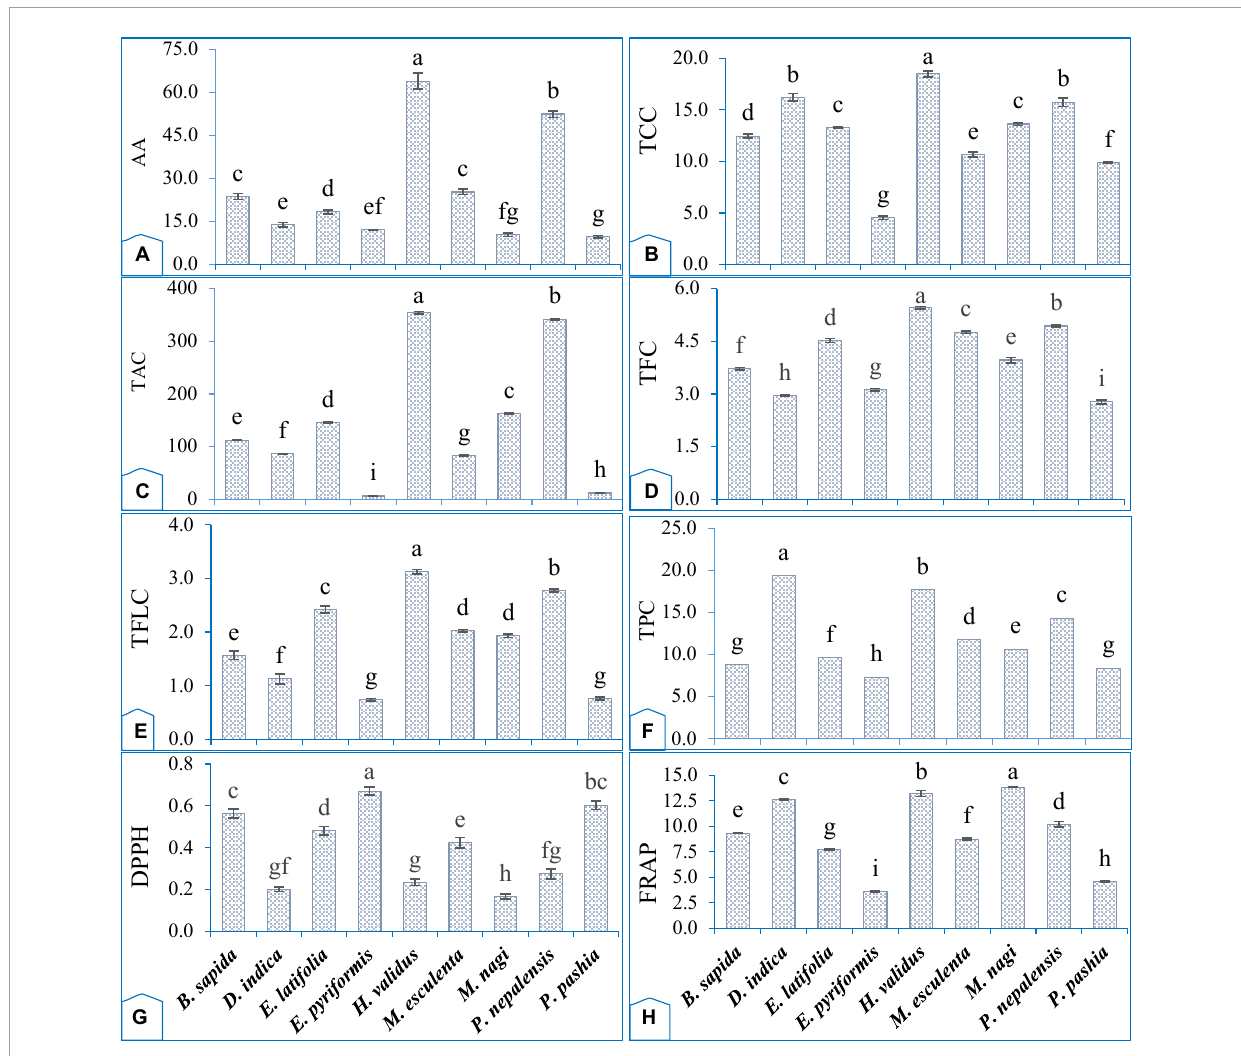
FIGURE3 Functional attributes of wild edible fruits grown in the eastern Himalayas, India. (A) Ascorbic acid content (AA, mg/100 g fw); (B) total carotenoids content (TCC, mg/100 g fw); (C) total monomeric anthocyanins content (TAC, mg/100 g fw); (D) total flavonoids content (TFC, mg QE /g); (E) total flavonol content (TFLC, mg QE /g); (F) total phenol content (TPC, mg GAE /g); (G) DPPH antioxidants capacity (DDPH, IC 50 value mg /mL); (H) FRAP antioxidants capacity (FRAP, mg AAE/g) content in wild edible fruits. IC 50 ascorbic acid (0.012 ± 0.002). Mean value of three replications (each replication consisted 10 fruits) with ± S.E followed by different letters on each bar indicate significant difference from each other according to Tukey’s test ( p <